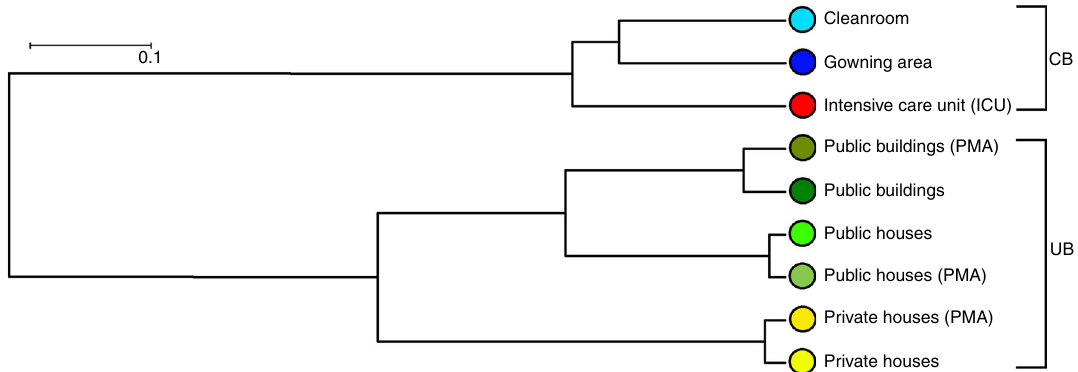
Fig. 2 Connection between different built environment types. UPGMA tree (Unweighted Pair Group Method with Arithmetic Mean tree) of sampled built environments based on different microbial communities resolved to species level. Calculations were executed with MEGAN according to the results of the BLASTx searches against NCBInr. Data of single reads were fi ltered (unassigned reads were removed) and normalized (randomly and repeatedly subsampled to the smallest sample size). Color code for column environment: blue (cleanroom facility); red (intensive care unit); dark green (public buildings); light green (public houses); yellow (private